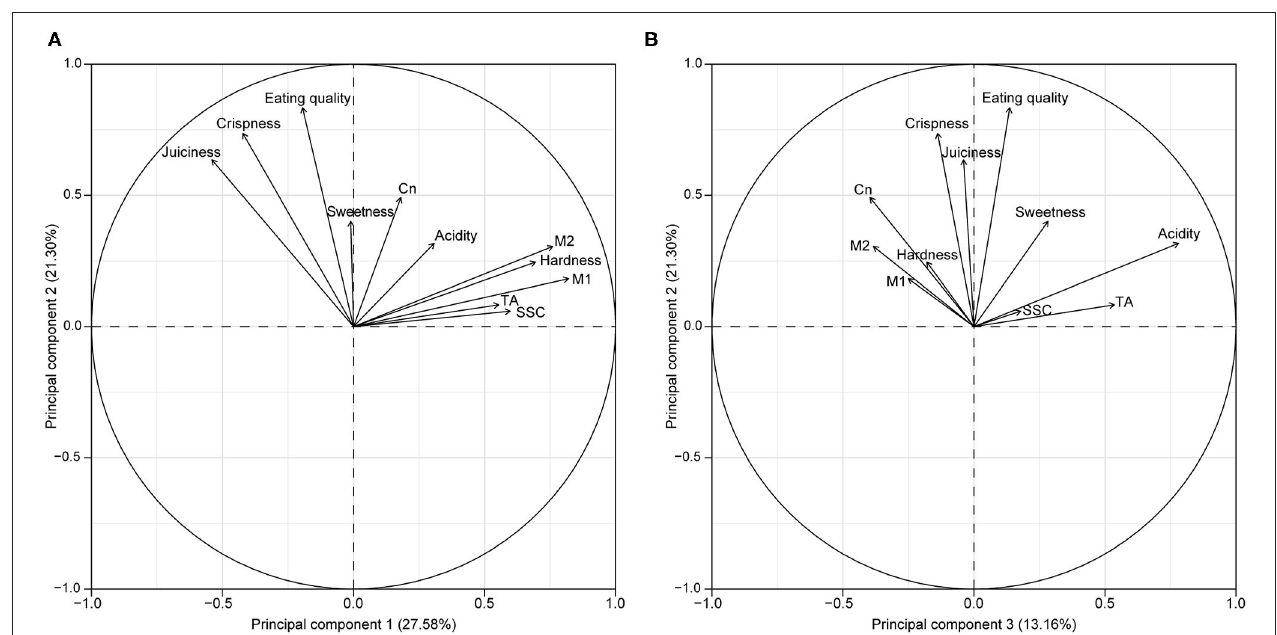
FIGURE 3 | Variable factor maps of principal component analysis (PCA) for instrumental and sensory fruit quality traits of Washington State University apple breeding program for phase two selections from 2009 to 2019. Variable factor maps for (A) PC1 and PC2 and (B) PC2 and PC3.